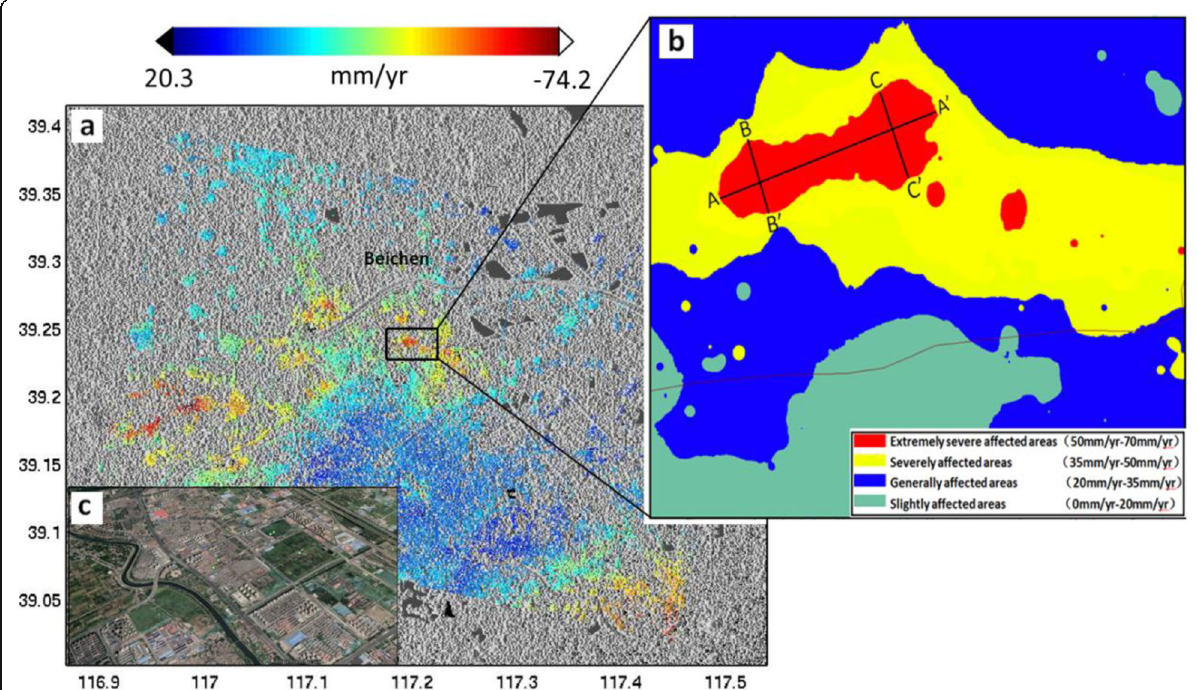
Fig. 9 Figure of subsidence risk ratings of Beichen District. a Subsidence rate of the Beichen District. b Subsidence risk of Beichen District. c A field picture of the Beichen District. The figure is plotted in the WGS 84 coordinate